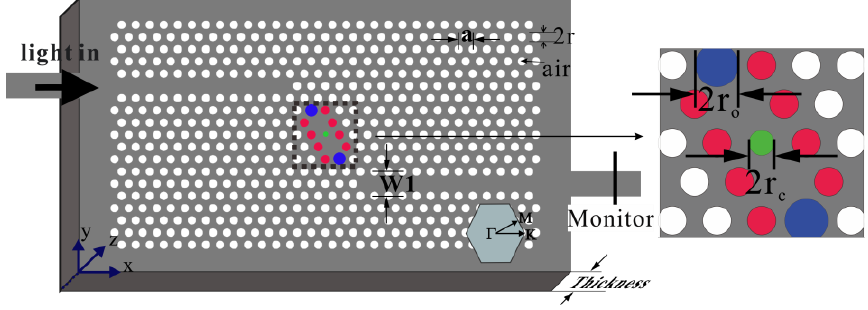
Figure 1. Schematic of the sensor configuration.